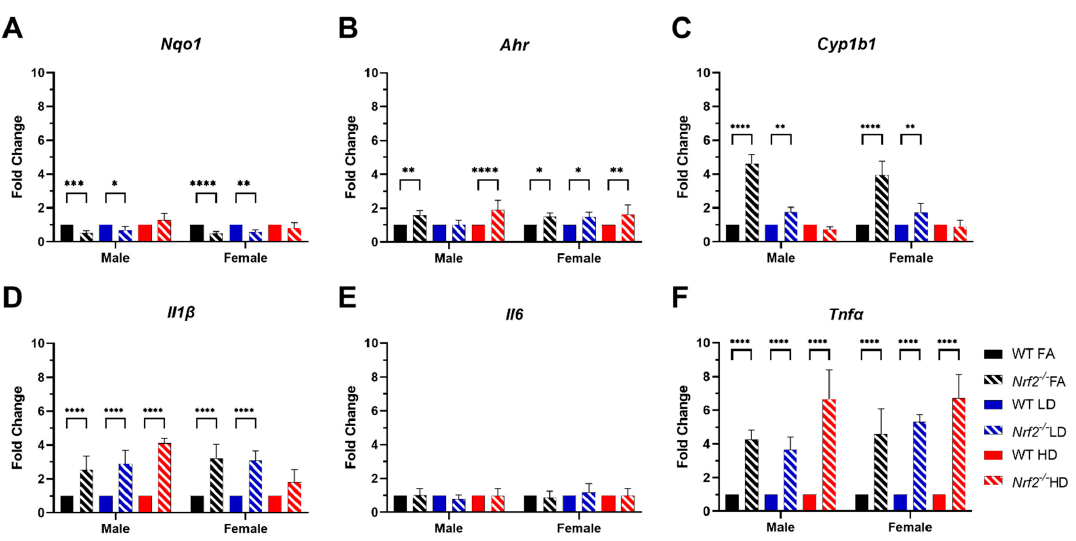
Figure 5. Oxidative stress biomarkers. Glutathione/glutathione disulfide (GSH/GSSG) and cys- teine/cystine (Cys/CySS) ratios with comparisons of WT and Nrf2 − / − exposed to filtered air (FA) control (black), low dose (LD) (blue), or high dose (HD) (red) for maternal serum ( A , D ) and placenta homogenates from male ( B , E ) and female ( C , F ) offspring. Error bars represent SD. Data analyzed using one-way ANOVA with Tukey’s multiple comparison test. (* p < 0.05; ** p < 0.01). Sample sizes for maternal serum: WT FA ( n = 5), WT LD ( n = 6), WT HD ( n = 5), Nrf2 − / − FA ( n = 3), Nrf2 − / − LD ( n = 3), Nrf2 − / − HD ( n = 5). Sample sizes for placenta from male offspring: WT FA ( n = 6), WT LD ( n = 11), WT HD ( n = 6), Nrf2 − / − FA ( n = 7), Nrf2 − / − LD ( n = 7), Nrf2 − / − HD ( n = 15). Sample sizes for placenta from female offspring: WT FA ( n = 10), WT LD ( n = 13), WT HD ( n = 12), Nrf2 − / − FA ( n = 8), Nrf2 − / − LD ( n = 4), Nrf2 − / − HD ( n = 14).